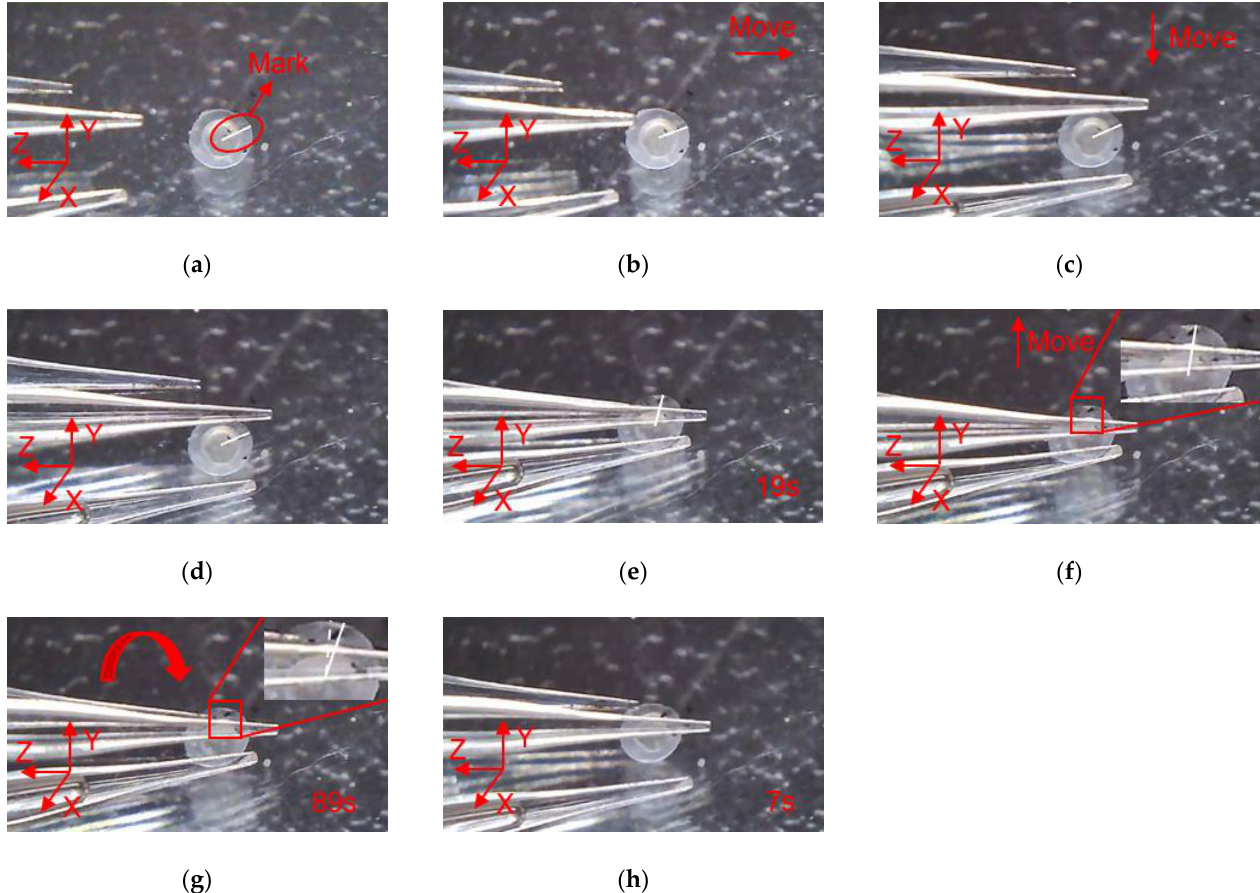
Figure 18. Manipulation of a embryo: ( a ) Initial state; ( b ) Microgripper is moved to approach the embryo; ( c ) The microgripper is moved downward to approach the embryo; ( d ) The microgripper is reached to the clamping position; ( e ) The embryo is clamped; ( f ) The embryo is move upward; ( g ) The embryo is rotated about axis X; ( h ) The embryo is released.